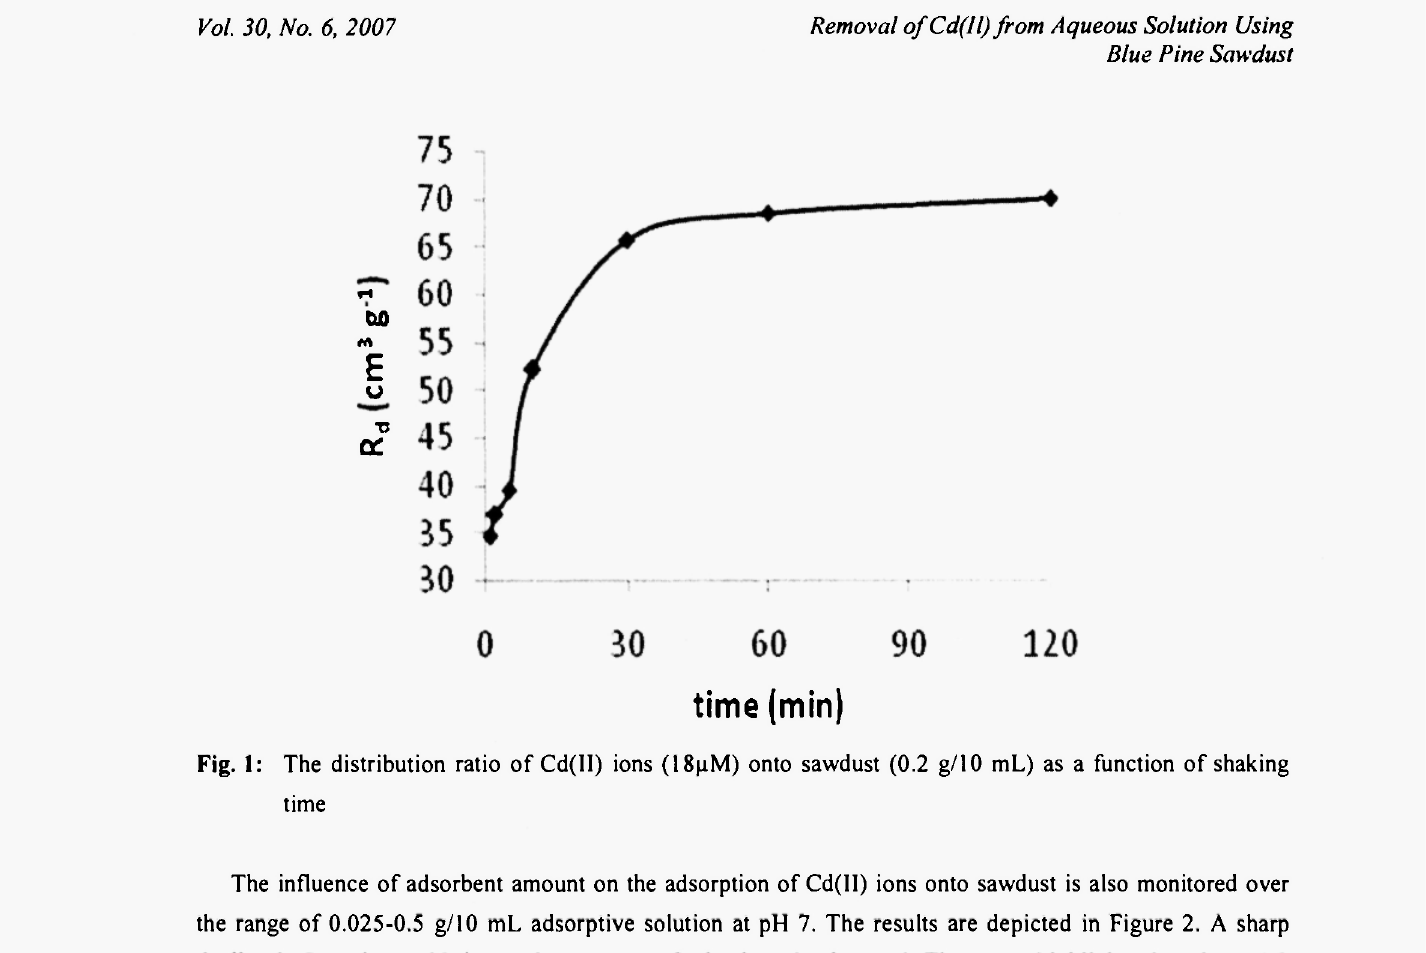
Fig. 1: The distribution ratio of Cd(II) ions (18μΜ) onto sawdust (0.2 g/10 mL) as a function of shaking